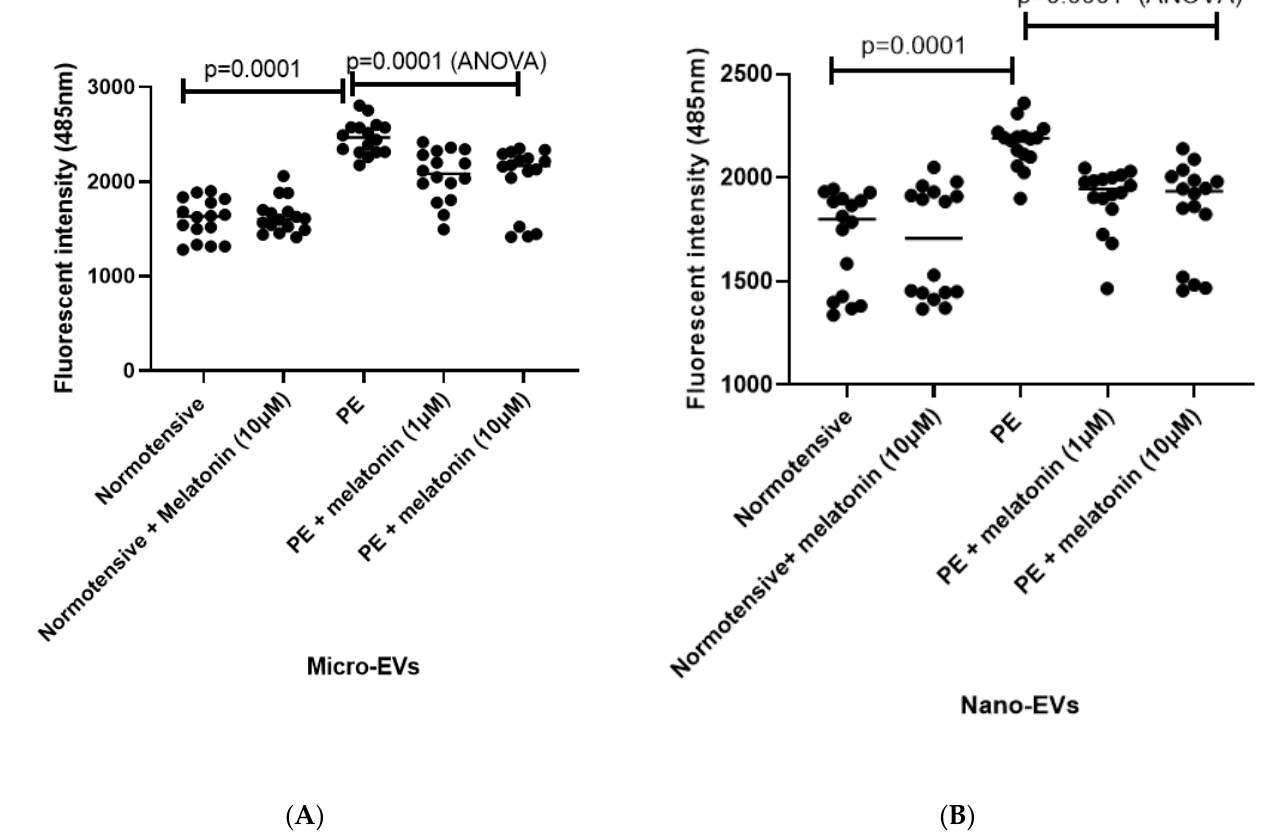
Figure 3. The misfolded proteins in placental micro-EVs ( A ) and nano-EVs ( B ) collected from either preeclamptic (PE) or normotensive placentae were measured by ThT fluorescent intensity. The statistical analysis was assessed by an ANOVA test or a Mann–Whitney U-test, when appropriate.